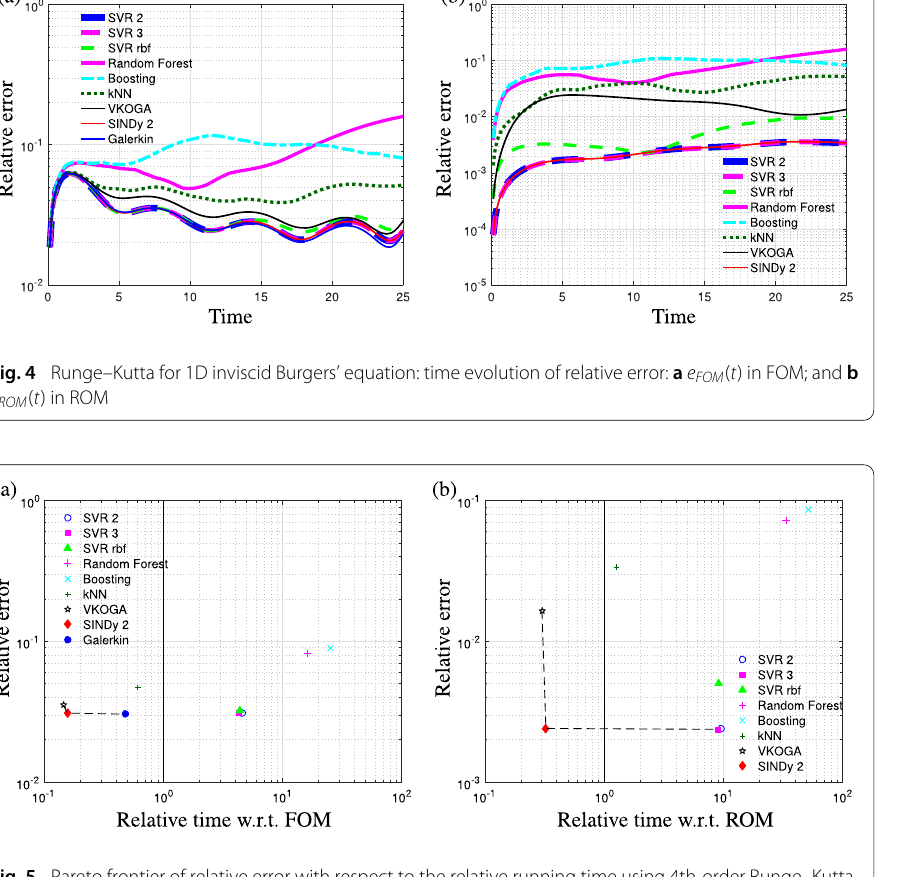
Fig. 5 Pareto frontier of relative error with respect to the relative running time using 4th-order Runge–Kutta for 1D inviscid Burgers’ equation: a e FOM vs. τ FOM in FOM; b e ROM vs. τ ROM in ROM